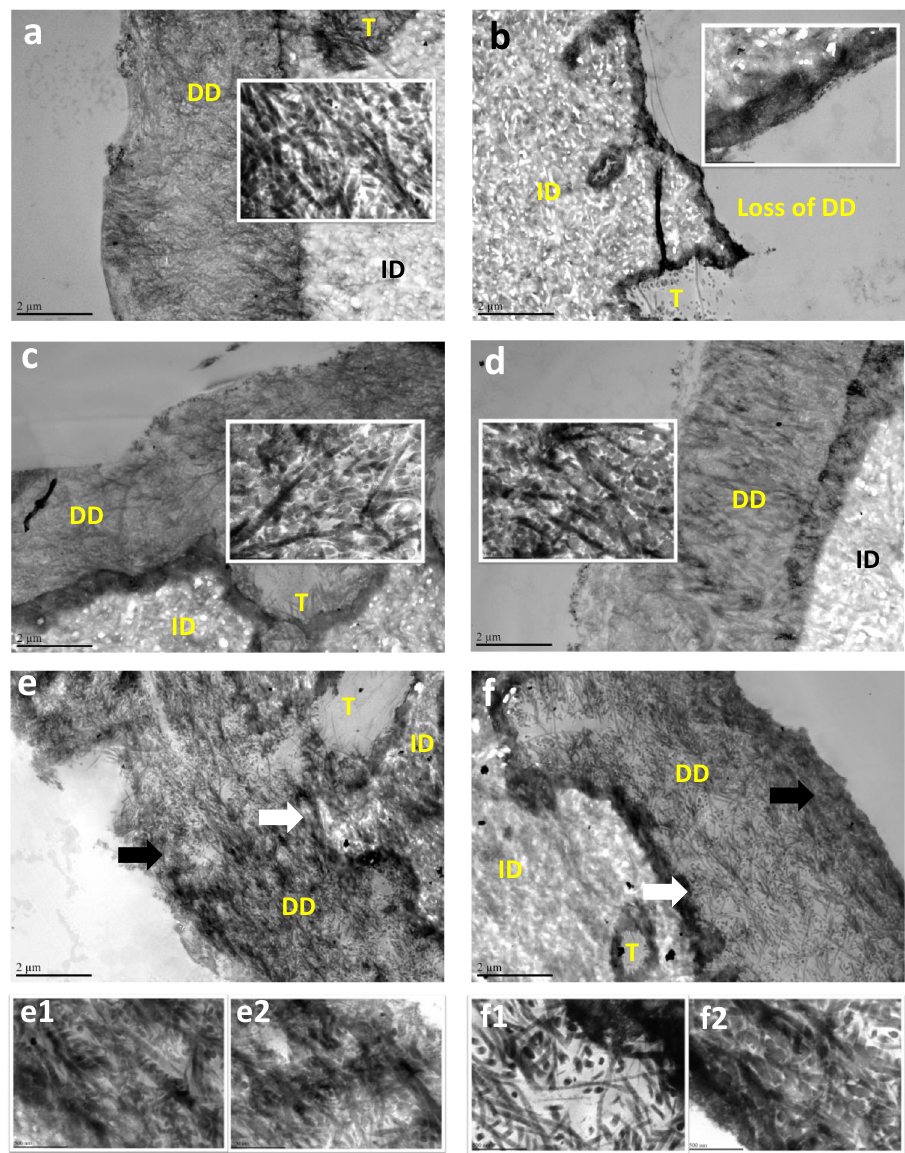
Figure 5. TEM images of acid-etched dentin without treatment ( a ) before and ( b ) after digestion (in 0.1% collagenase at 37 °C for 1 h); treated with 2.0% TF for 30 s followed by digestion ( c ); treated with 2.0% PA for 30 s followed by digestion ( d ); treated with 0.4% TF for 30 s followed by digestion ( e ); and treated with 0.4% PA for 30 s followed digestion ( f ). Representative high magnification view of the demineralized dentin (DD) layer shown as inset ( a – d ); high magnification view of the bottom region (white arrow position) in DD layer ( e1 and f1 ); high magnification view of the top region (black arrow position) in DD layer ( e2 and f2 ). DD: demineralized dentin. ID intact dentin. T